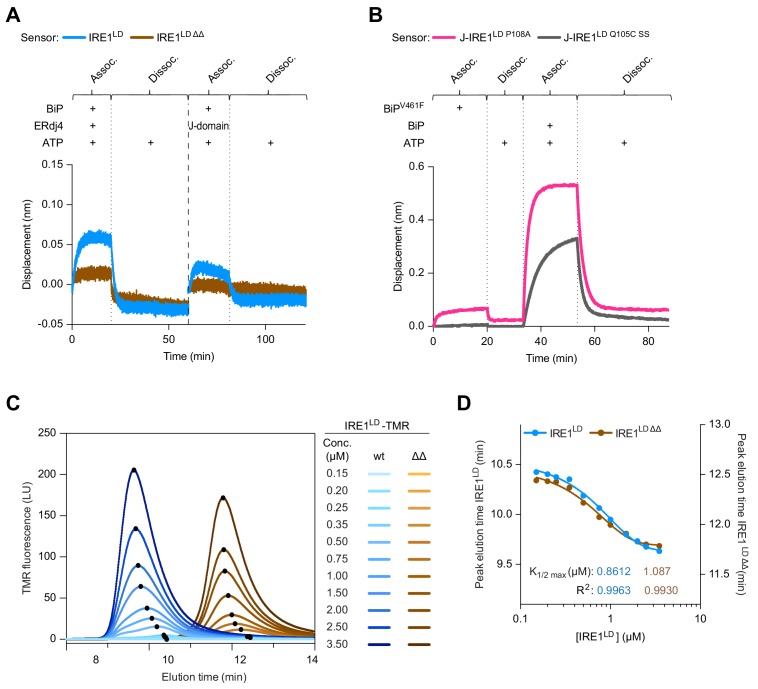
The ∆∆ deletion does not affect the stability of the IRE1LD dimer.(A) Bio-Layer Interferometry (BLI)-derived association (assoc.) and dissociation (dissoc.) traces of streptavidin sensors loaded with the indicated biotinylated ligands [wild-type (wt) or IRE1LD ∆∆] and exposed sequentially to the indicated solutions of analyte. 2 µM BiP, 6.8 µM full-length ERdj4, or isolated J-domain and 2 mM ATP. A representative experiment of three independent repetitions is shown (processed as in Figure 5A). (B) As in Figure 5A but comparing the monomeric J-IRE1LD P108A and the disulphide-linked J-IRE1LD Q105C SS proteins as ligands on the sensor. A representative experiment of three independent repetitions is shown. (C) Size-exclusion chromatography (SEC) elution profiles of TAMRA (TMR)-labelled wt and IRE1LD ΔΔ proteins at the indicated concentrations. TMR fluorescence is plotted against elution time [note: fluorescent labelling was used to detect a signal at the low protein concentration (conc.) required to generate a pool of monomeric IRE1LD] (see: Figure 5—source data 2) (D) Plot of peak elution time points derived from ‘C’ against the protein concentration on a logarithmic scale for IRE1LD and IRE1LD ΔΔ. Curve fitting was performed in Prism GraphPad 7.0 using a sigmoidal function and calculated K1/2 max values are displayed underneath the curves.Figure 5—figure supplement 1—source data 1.Source data for Figure 5—figure supplement 1B.Figure 5—figure supplement 1—source data 2.Source data for Figure 5—figure supplement 1C.